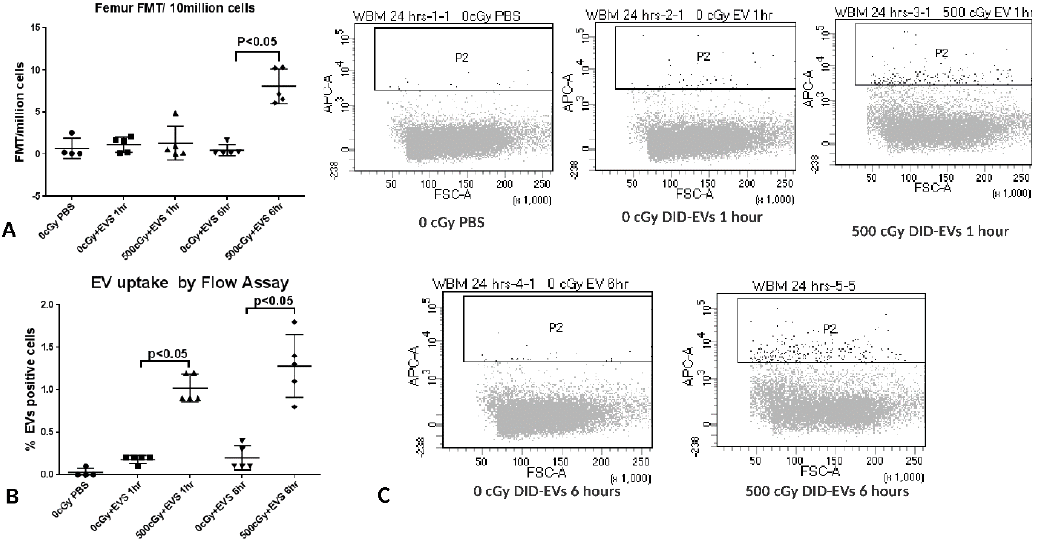
Figure 8. EV accumulation in tissues from 0 or 500 cGy radiation exposed mice at 1 and 6 h post-systemically administered EVs. ( A ) EVs in the bone marrow cells determined by FMT. The intensity of fluorescence was expressed as the average of fluorescence intensity (count/energy)/10 million bone marrow cells ± SEM. ( B ) The DiD positive bone marrow cells harvested from femurs were detected by flow cytometry. The one-way ANOVA with a multiple comparisons test was performed. A P value ≤ 0.05 was considered statistically significant, 500 cGy + EVs 1 h, or 500 cGy + EVs 6 h versus non-irradiated + PBS. ( C ) Flow cytometry diagrams of DiD-positive bone marrow cells from 0 or 500 cGy radiation exposed mice at 1 and 6 h post EV injection. n = 5 mice/group.